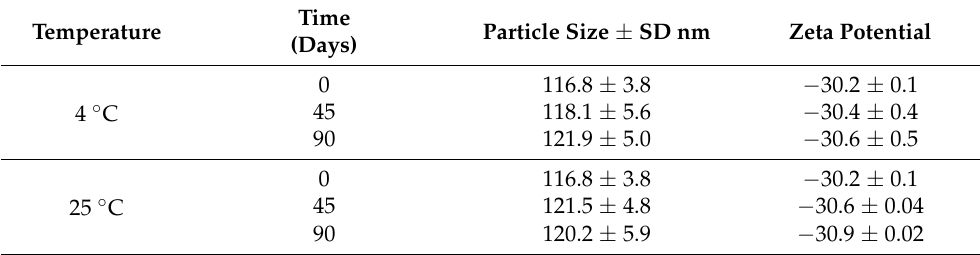
Table 1. Stability study of optimized BSA-SPIONs-TMX at 4 °C and 25 ± 2 °C/60 ± 5% RH for 90 days ( n = 3) (solvent = Milli-Q water).